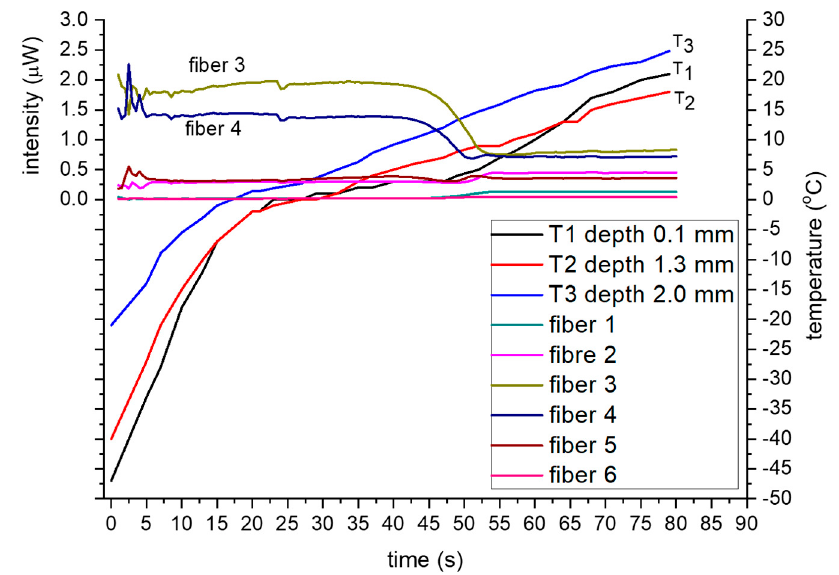
Figure 7. 2D timelines of intensities and temperature showing the temporal, temperature, and optical backscattering intensities for 3 depths (0.2 mm, 1.3 mm, and 2.1 mm).